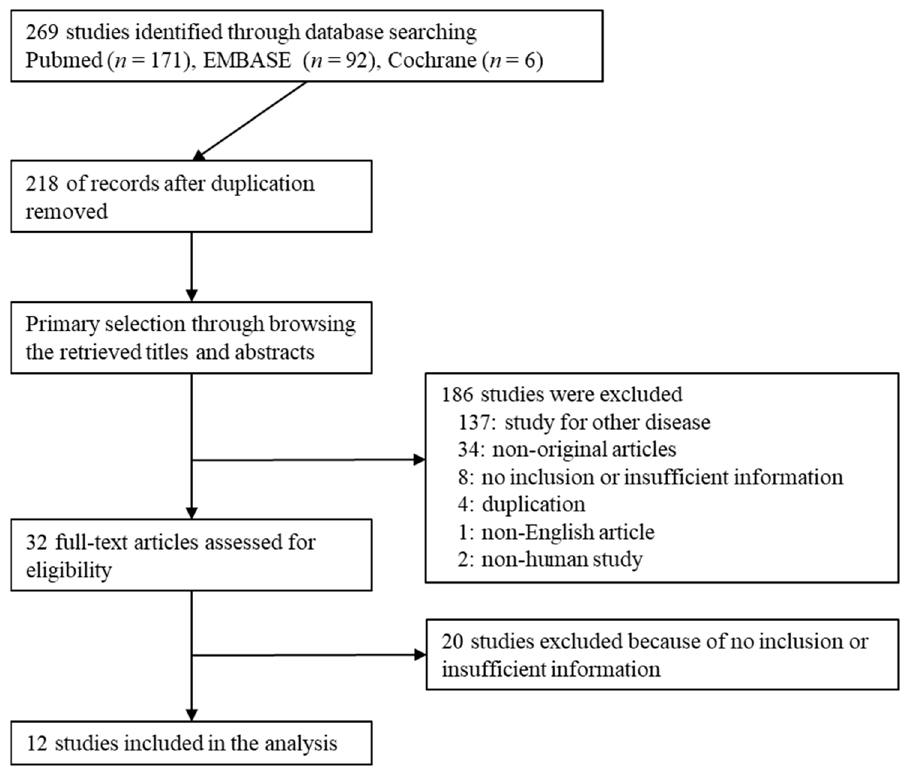
Figure 1. Flow diagram for identification of eligible studies. Table 1. Main characteristics of the eligible studies.